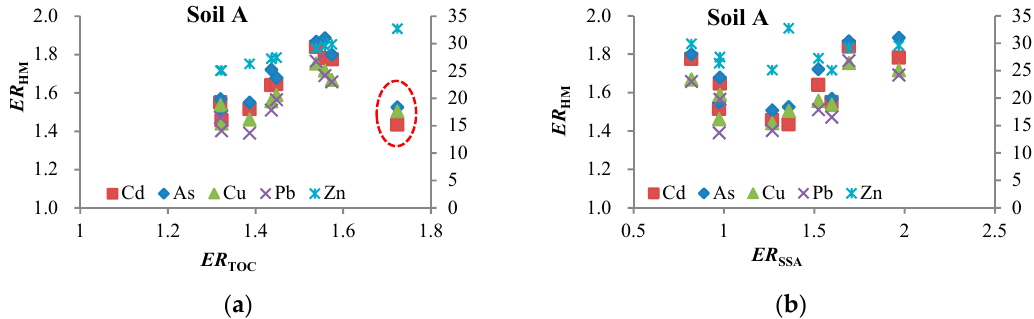
Figure 8. Relationships between the enrichment ratios for ( a ) heavy metals and metalloids ( ER HM ) and total organic carbon ( ER TOC ), and ( b ) heavy metals ( ER HM ) and specific surface area ( ER SSA ) in soil A. Note the y-axis in the left represents Cd, As, Cu, Pb and in the right it represents Zn; the data in the dashed circles were obtained from the first sample since the runoff and sediment yield were not stable, the data were assumed as outliers for model estimation.